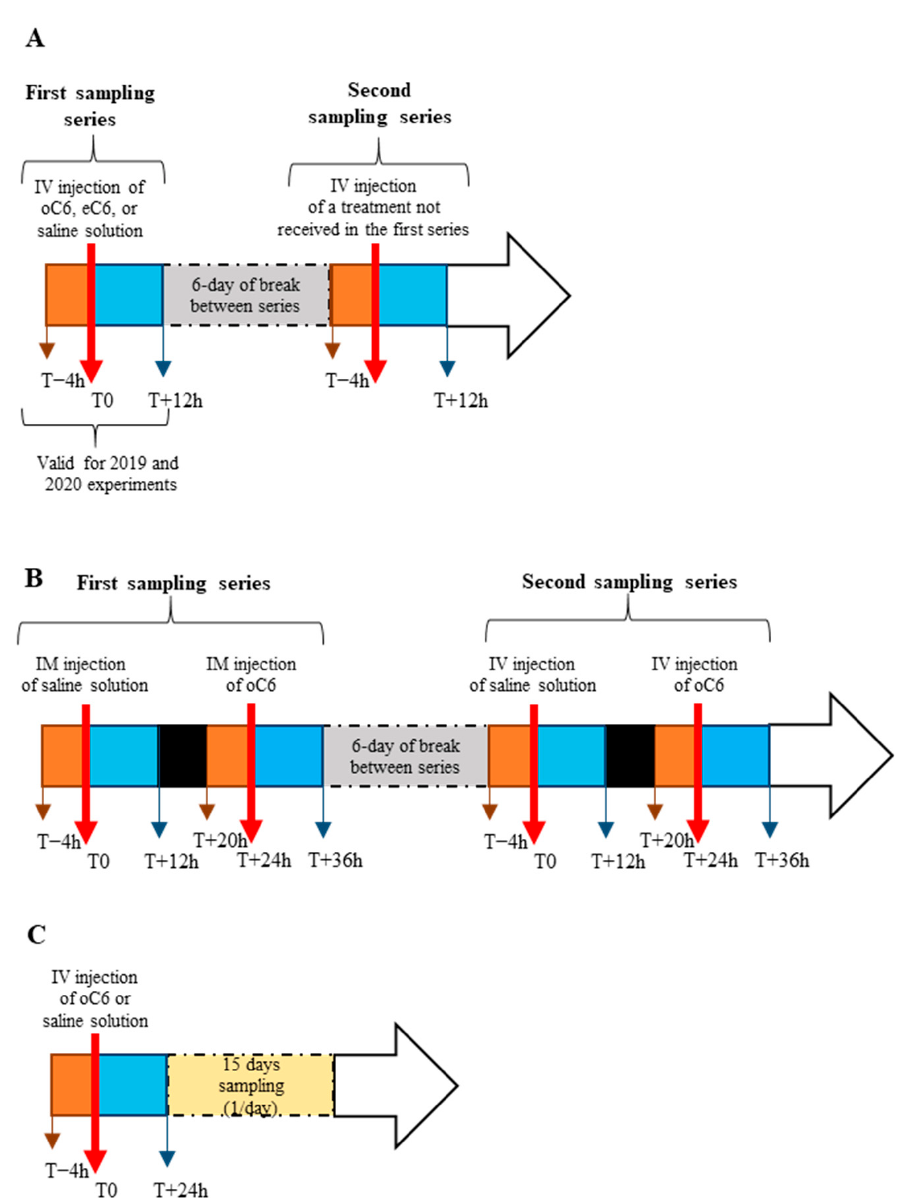
Figure 1. Schematic representation of protocols for experiment 1 ( A ), experiment 2 ( B ), and experi- ment 3 ( C ). Red arrows and T0 indicate the time of treatment administration. T+/ − Xh indicate the time before or after the first administration of treatment during a sampling series. Orange boxes represent the sampling period before treatment administration. Black boxes represent a break in blood sampling. Grey boxes indicate the time intervening between two experimental series. The yellow box represents the time window of blood collection for P4 measurement.